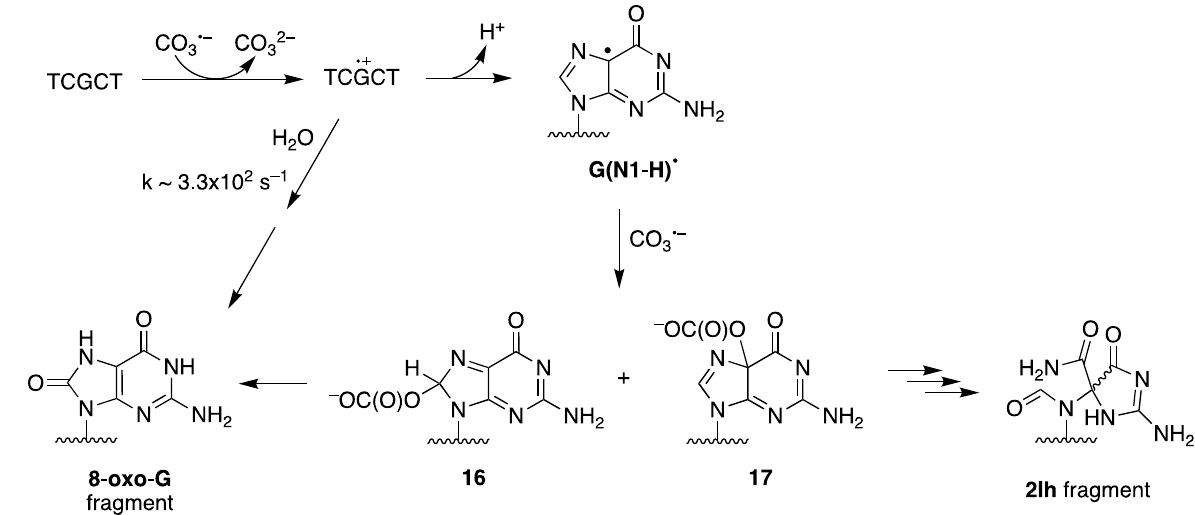
Figure 9. Mechanistic scheme of one-electron oxidation of ss-ODN (TCGCT) by carbonate radical anion CO 3• − (adapted from ref. [54].